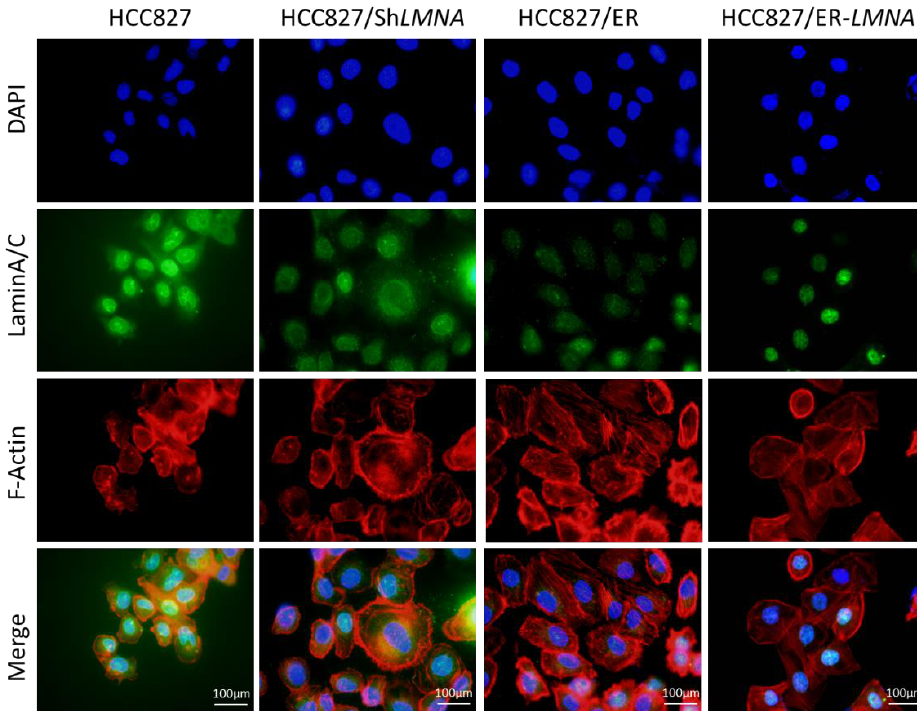
Figure 6. LMNA regulation of cytoskeletal changes and nuclear deformability. Cytoskeletal F-actin was stained with rhodamine phalloidin (red). Nuclei were visualized using DAPI staining (blue). LaminA/C was determined by immunofluorescence assay (green). Representative pictures of fluorescent laminA/C, F-actin, and nuclei are shown. Scale bar = 100 μm.